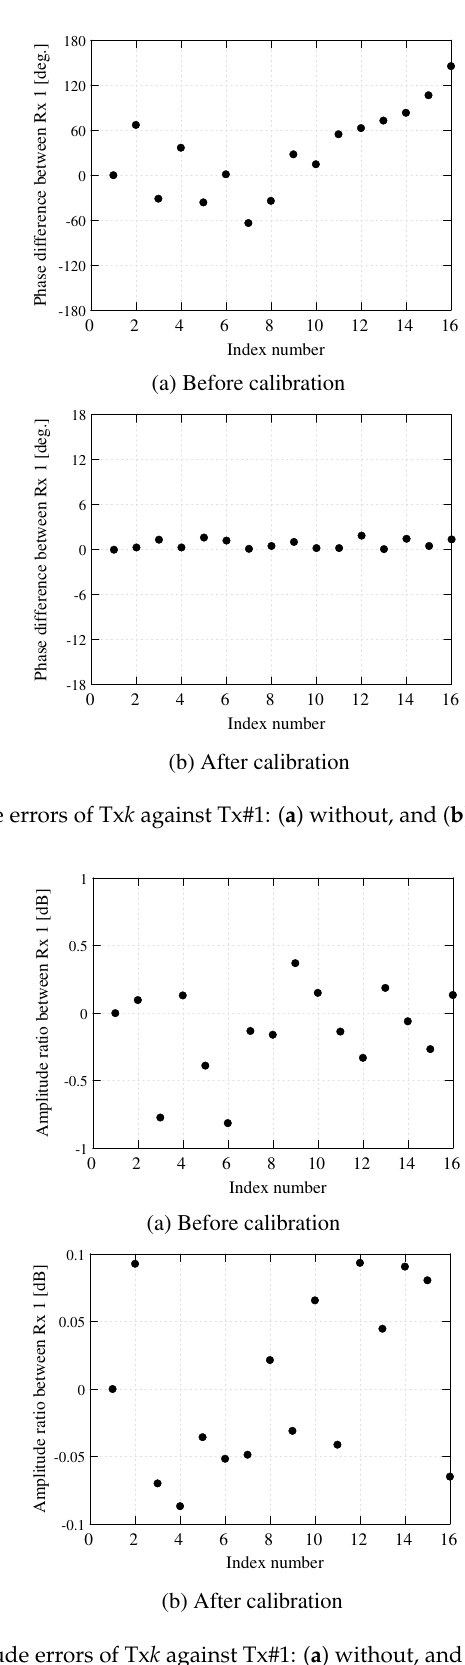
Figure 7. Amplitude errors of Tx k against Tx#1: ( a ) without, and ( b ) with